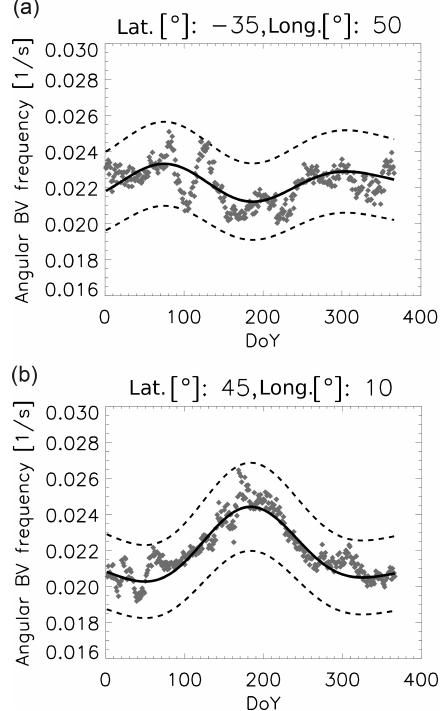
Figure 5. Comparison of the approximation of the BV frequency (solid line) with the approximated values for two different bins. The dashed line refers to the ± 10% interval around the approximation.